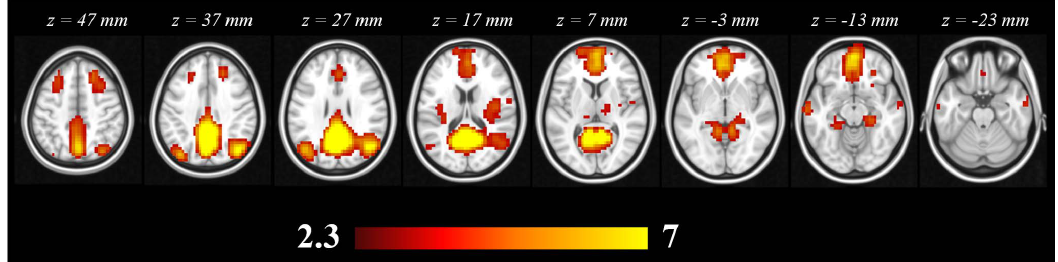
Figure 3. DMN identified from the group analysis of the 15 subjects.